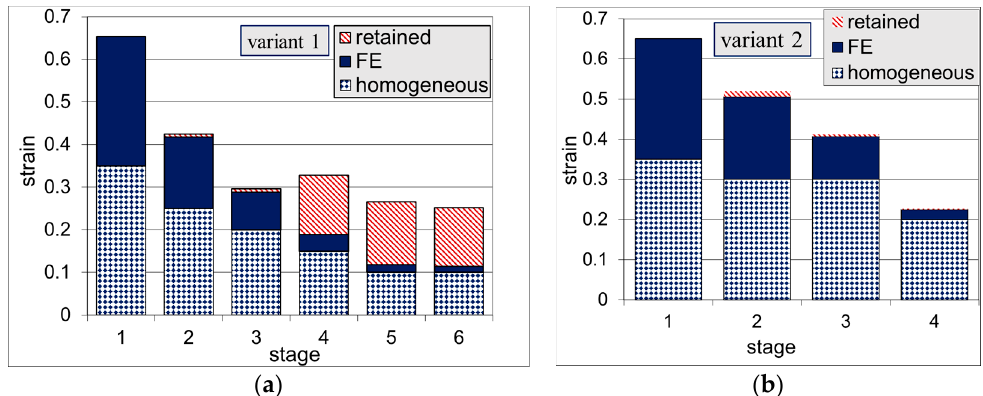
Figure 12. Homogeneous strains ( ε h ), strains in the center of the sample calculated by the finite element (FE) code and retained strains for bainitic steel variant 1 ( a ) and variant 2 ( b ). Prediction of the microstructure evolution was the next objective. Results of simulations of grain size evolution during the tests in the center of the sample are shown in Figure 13a. Variant 1 leads to much finer grains at the beginning of phase transformations (after the last deformation). Changes of the recrystallized volume fraction are shown in Figure 13b. Full recrystallization was predicted at all stages of the variant 2. On the contrary, partial recrystallization was predicted at the two final stages of the variant 1. In consequence, phase transformations in this variant occur in the non-recrystallized austenite. Distribution of the grain size after last pass of the variant 1 is shown in Figure 13c. This figure confirms strong inhomogeneity of the test.